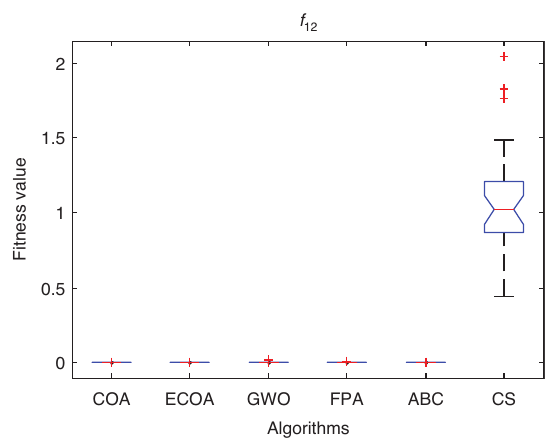
Figure 24: D = 30, ANOVA Test of Global Minimum for f